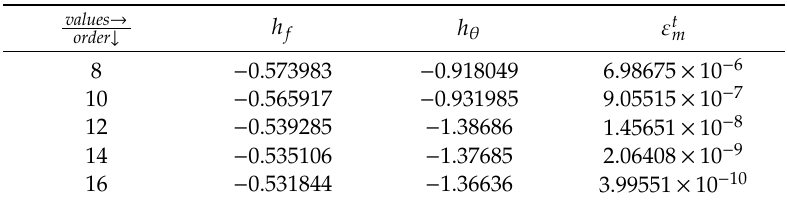
Table 2. Average residual square errors ( ε t m ).